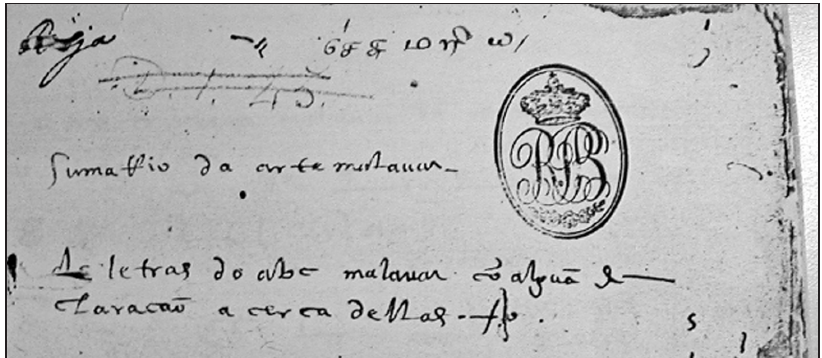
Figure 1: Beginning of the 16th cent. Arte attributed to Henrique Henriques (HH) (cod. 3141, Biblioteca Nacional de Portugal, Lisbon).